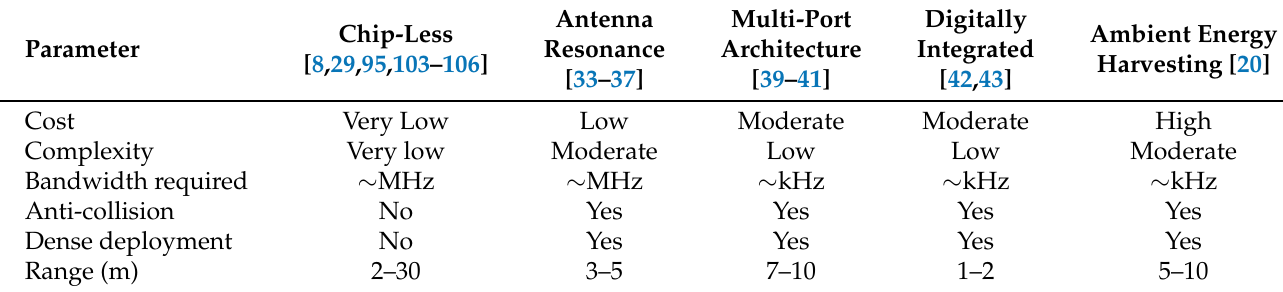
Table 1. Comparison of the five RFID-based sensor topologies